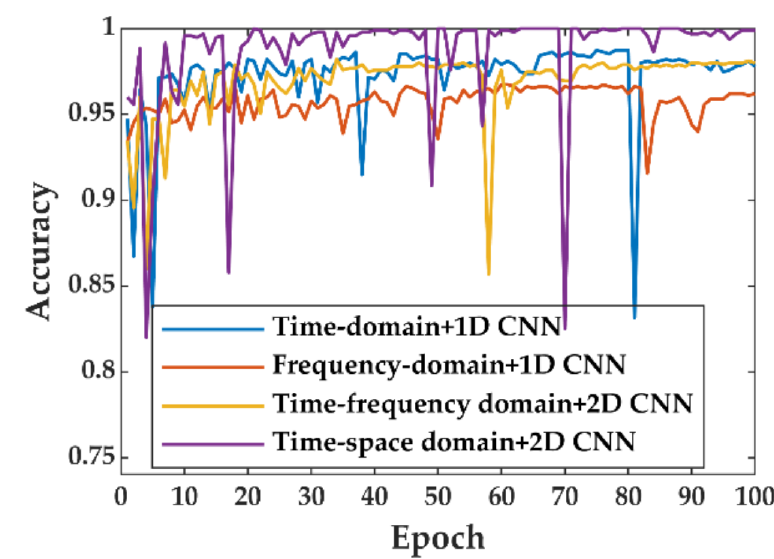
Figure 11. The accuracy curves of each epoch validation dataset.